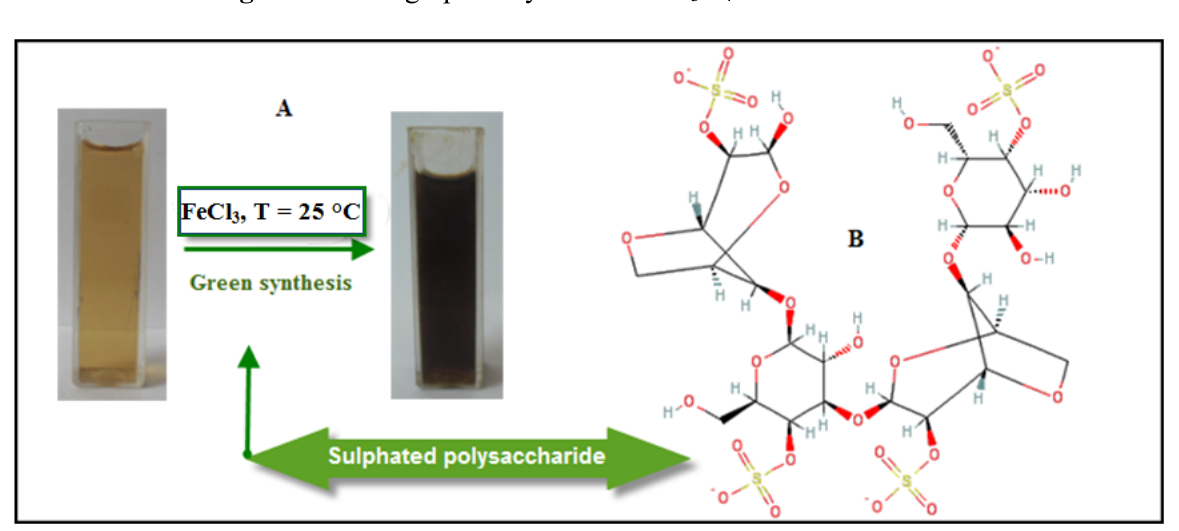
Figure 1. Photograph of synthesized Fe